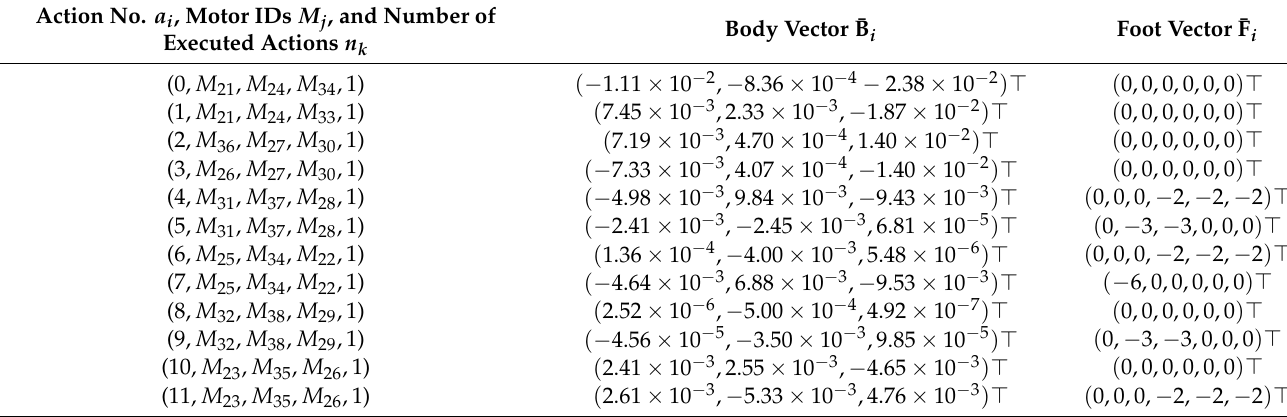
Table 3. Results of body calibration in Robot 1. This robot has motor IDs M 21 to M 38 . Action No. a i , Motor IDs M j , and Number of